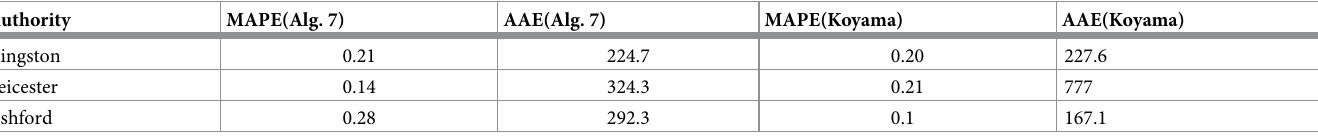
the aggregated reported cases via a probability distribution G with a mean driven by the under- lying Hawkes process. The usual options of G are Negative Binomial and Poisson distribution. We propose a KDPF for inferring the latent cases and the instantaneous reproduction number and for predicting the new observed cases over short time horizons. We demonstrate the per- formance of the proposed algorithm on COVID-19. The analysis of synthetic data shows that KDPF compares well with PMMH, having the advantage that it is a more computationally efficient algorithm than PMMH. We also demon- strate that our predicted new cases, and our inference for the latent intensity, the daily and weekly hidden cases are consistent with the observed cases in various local authorities in the UK. The simulation analysis shows that the proposed algorithm provides comparable esti- mates of observed case fluctuations compared with those of Koyama et al. [10]. The method of Koyama et al. [10] and EpiEstim provide similar estimates of the reproduction number to the proposed algorithm. The simulation analysis shows that working with daily reported infections leads to better Effective Sample Sizes using a smaller number of particles, as the data spikes are reduced. Table 5. The MAPE and AAE of estimated observed cases over next week projected by Algorithm 7 and the method of Koyama et al. [10] using a rolling-window analysis in local authorities.